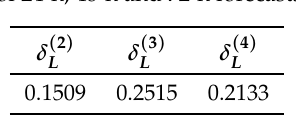
Table 5. Accuracy of 24-h, 48-h and 72-h forecasts using LT ξ